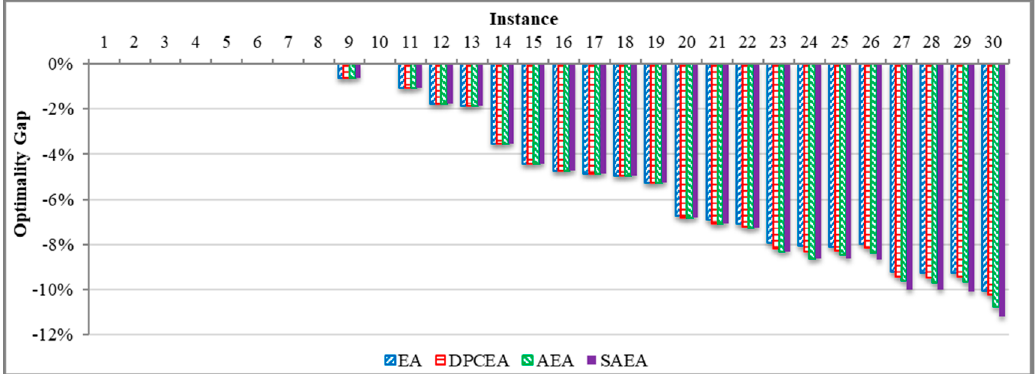
Figure 9. The optimality gaps of the developed solution algorithms.